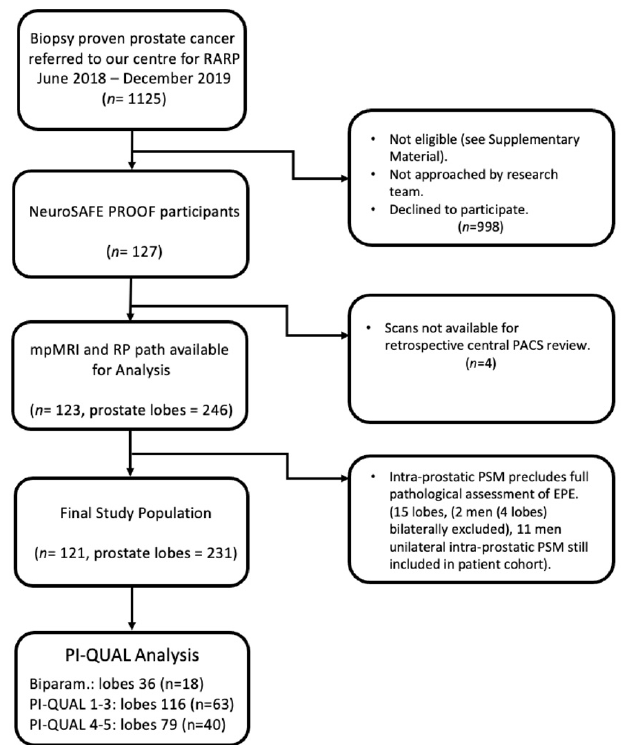
Figure 1. Flow diagram of patient selection for study. Abbreviations : RARP, robot-assisted radical prostatectomy; PACS, picture archiving and communication system; RP, radical prostatectomy; PSM, positive surgical margin; EPE, extra-prostatic extension, PI-QUAL, Prostate Imaging Quality score; Biparam., bi-parametric MRI scan.